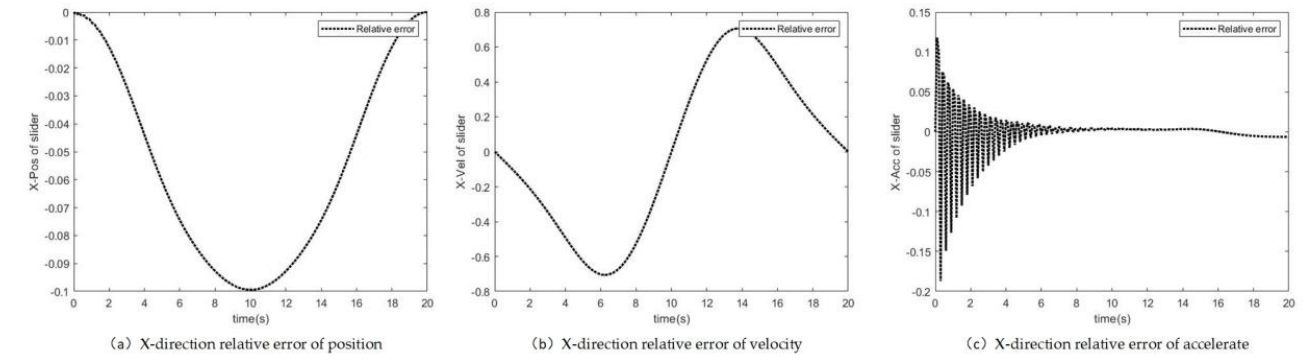
Figure 7. Relative kinematic parameters difference of slider in X direction.